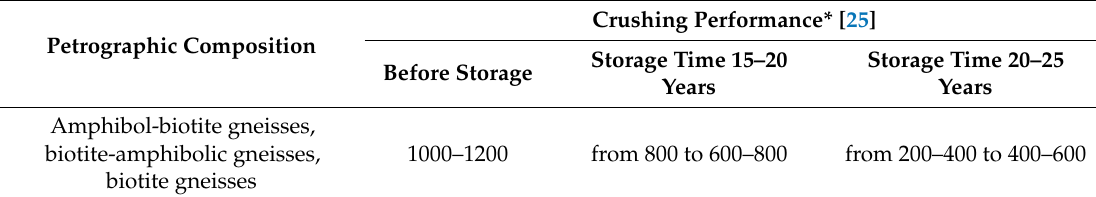
Table 2. Crushing performance of the overburden rock from JSC Olkon dumps.